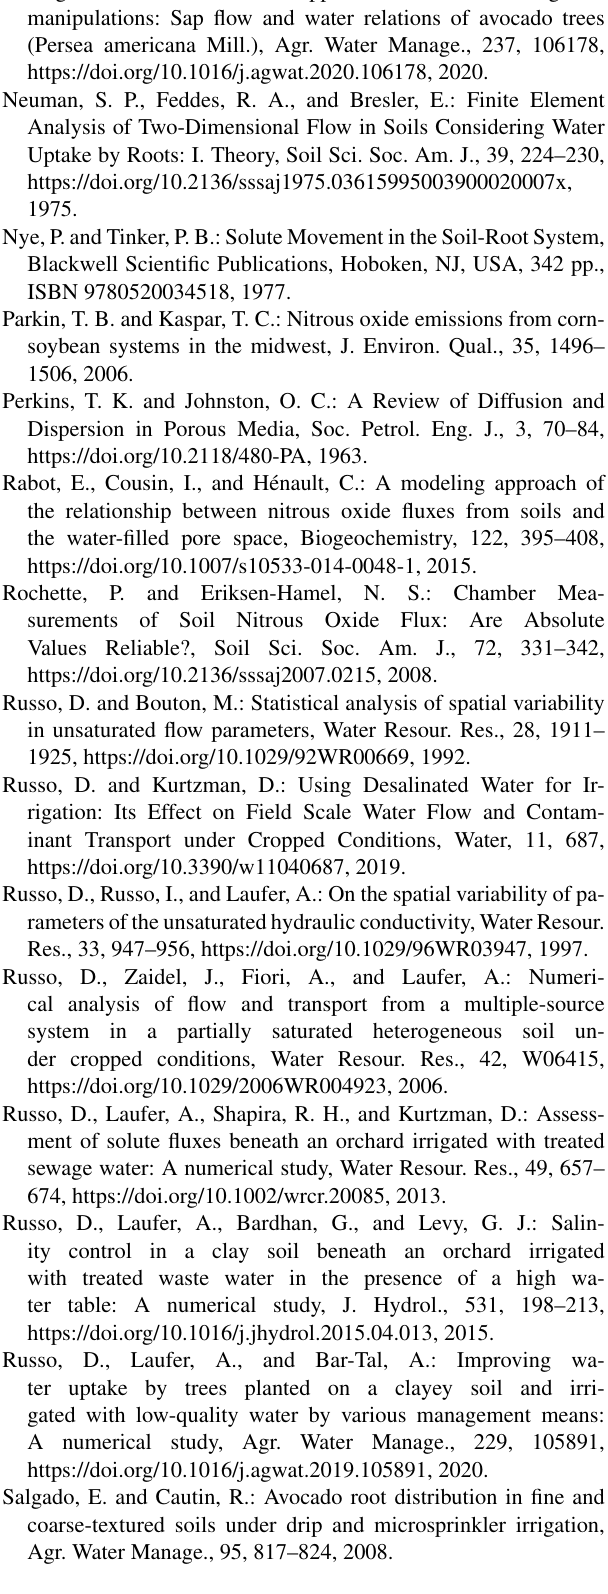
ter table: A numerical study, J. Hydrol., 531,